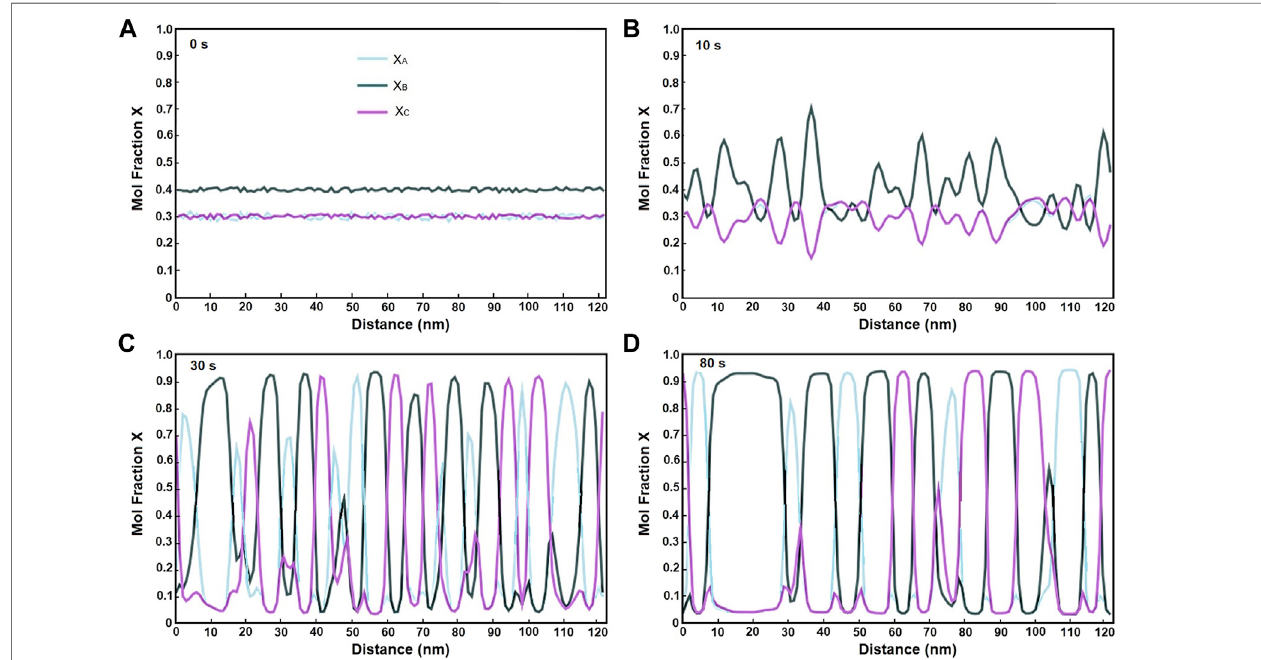
FIGURE 7 | Simulated concentration pro fi les of the A – B – C alloy for case II with X A = 0.3 , X B = 0.4 , and X c = 0.3 aged at 800 K for (A) 0 s, (B) 10 s, (C) 30 s, and (D) 80 s.